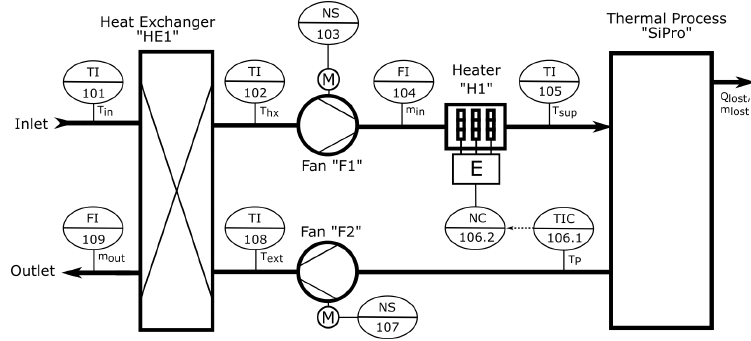
Figure 3. Use-case: Pipe and instrumentation diagram of the heating process.